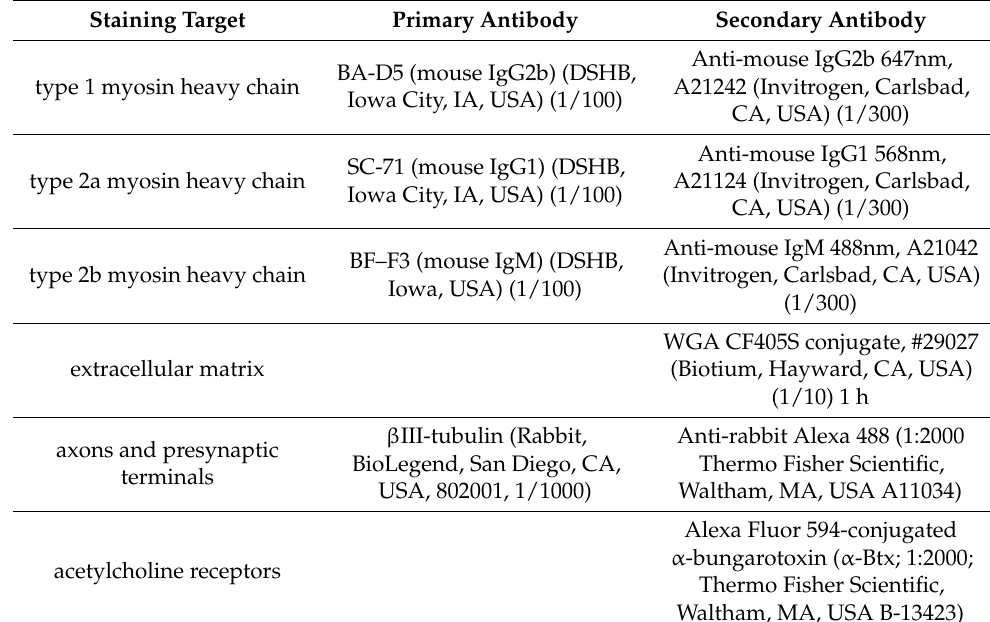
Table 1. Antibodies Used for Immunofluorescent